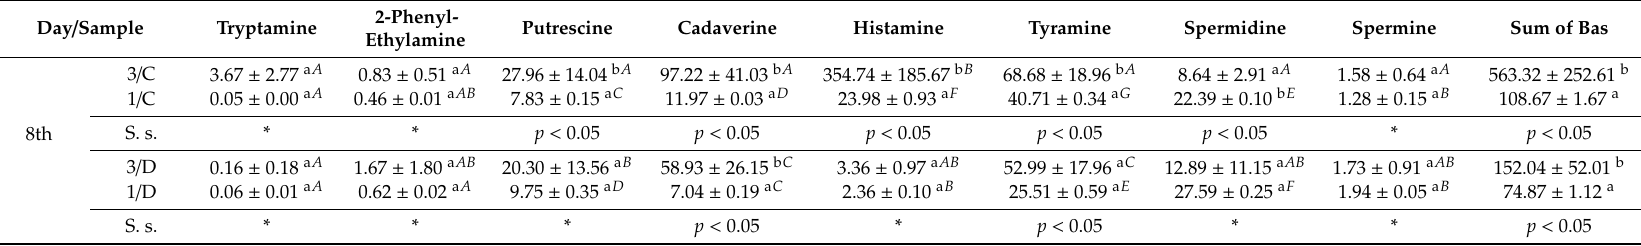
Table 4. Qualitative and quantitative BA spectrum (in mg · kg − 1 ) for three batches and for one batch for groups C and D / 8th day of sampling in a detailed